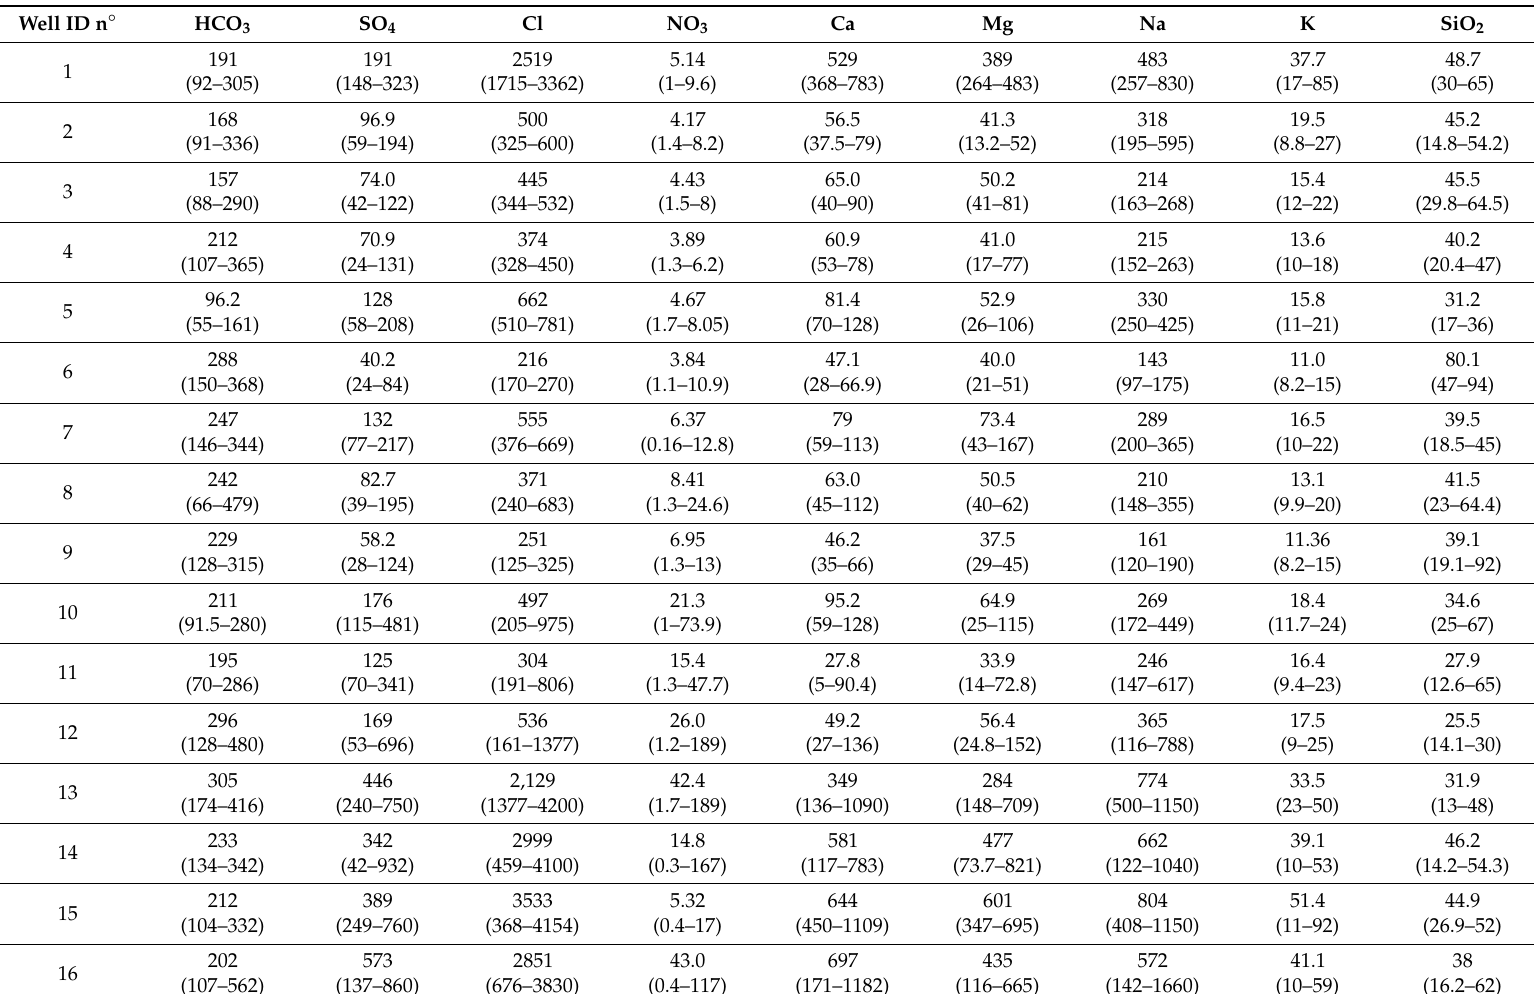
Table 4. Average concentration of prevailing ions (mg / L) and their rates (minimum and maximum values between